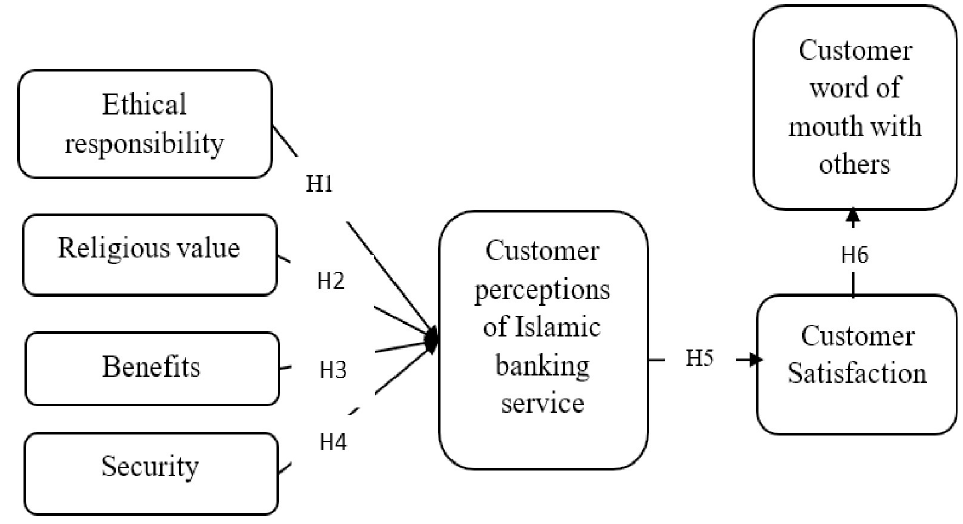
Fig 1. Research model: Author’s